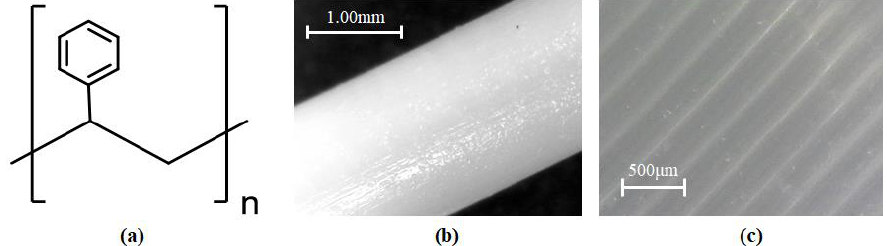
Figure 10. HIPS ( a ) chemical structure; ( b ) raw material; and ( c ) final processed material.